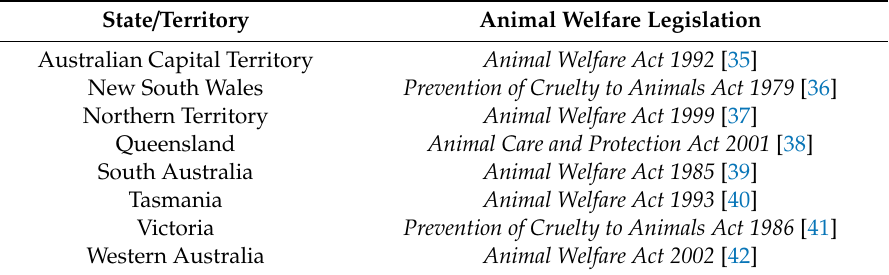
Table 1. Each state and territory’s relevant animal welfare legislation in